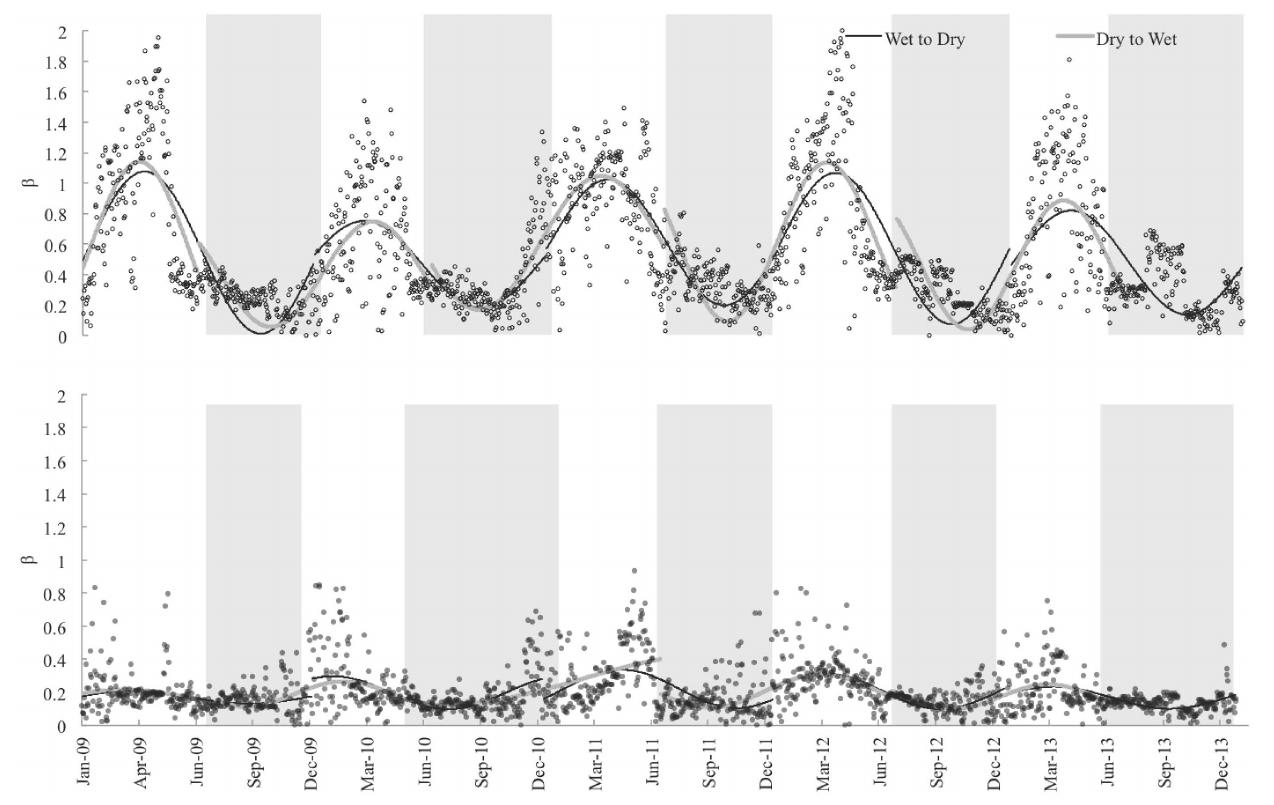
Fig. 2. Time series of b for (a) TS and (b) SRS. b was used to determine the change from dry to wet, and wet to dry seasons. Sine functions were fit to the b time series by year and by sites. The initiation of the dry season was determined by fitting a sine function annually (Jan 1 to Dec 31). The inflection point along the positively sloped portion of each sine function identified the change from dry to wet season. The initiation of the wet season was defined by fitting a sine function offset by 2 182 days ( , 6 months), and determining the inflection point along the negatively sloped portion of each sine function. The shaded region highlights the wet